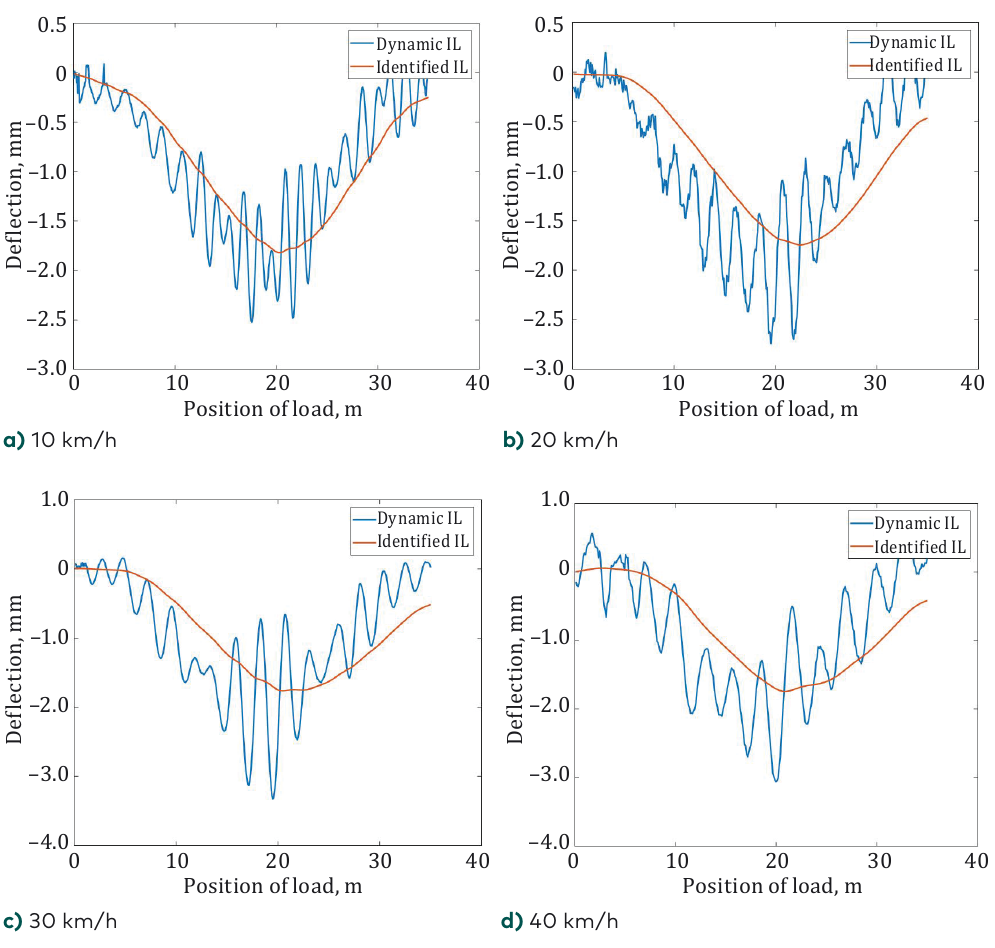
Figure 5. Identified results of the FIR